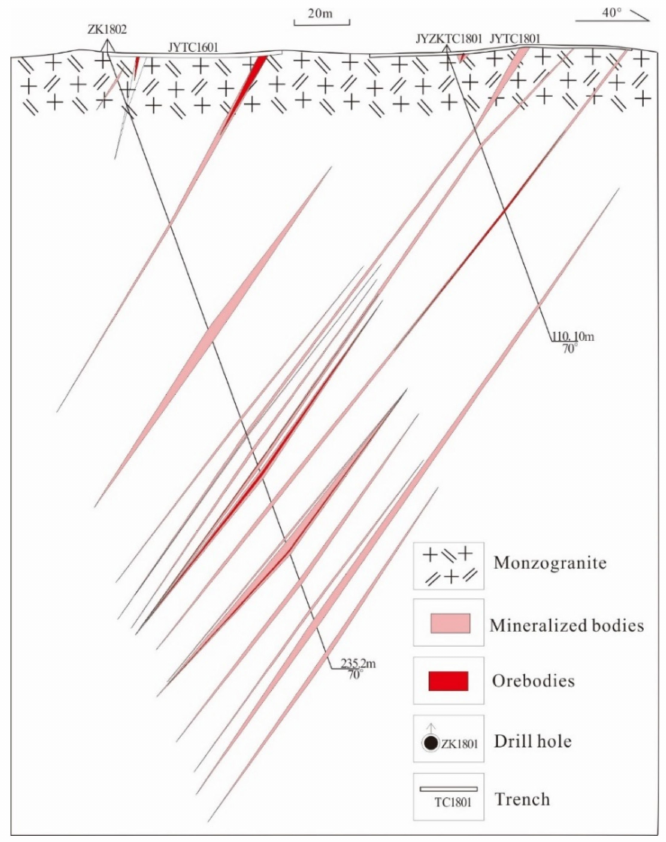
Figure 3. Geologic section of No. 18 prospecting lines at the Juyuan tungsten deposit.